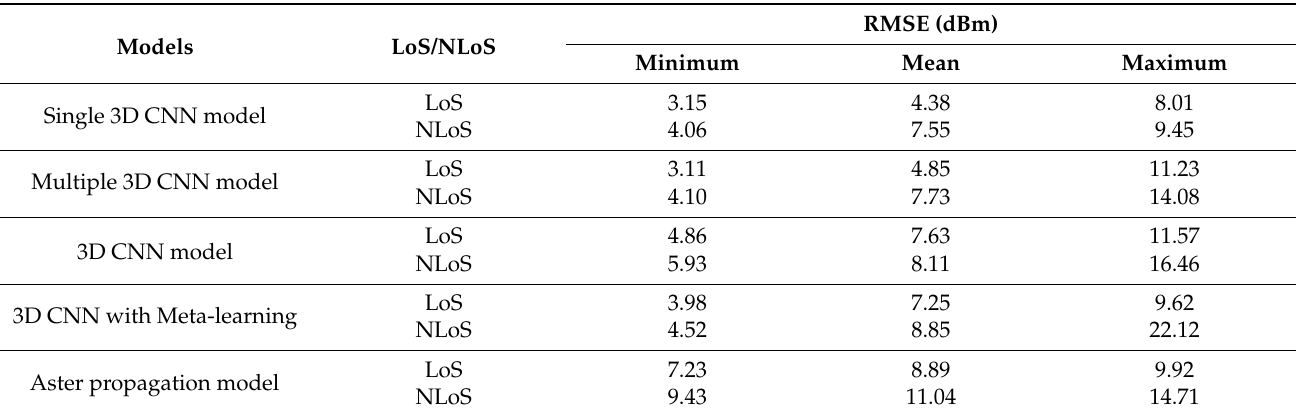
Table 6. Minimum, Mean, Maximum Comparison Root Mean Square Error of various methods